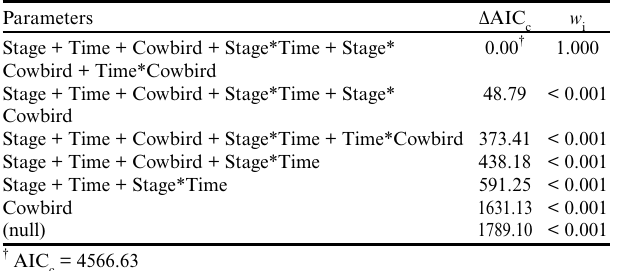
Table 7. Comparison of a priori selected models to assess the parasite-assessment hypothesis and the relationship between vocalization rate by male vireos and nest stage (Stage), time of day (Time), and local cowbird density (Cowbird). Models are compared using AIC (Akaike 1974) and model weights (wi) c